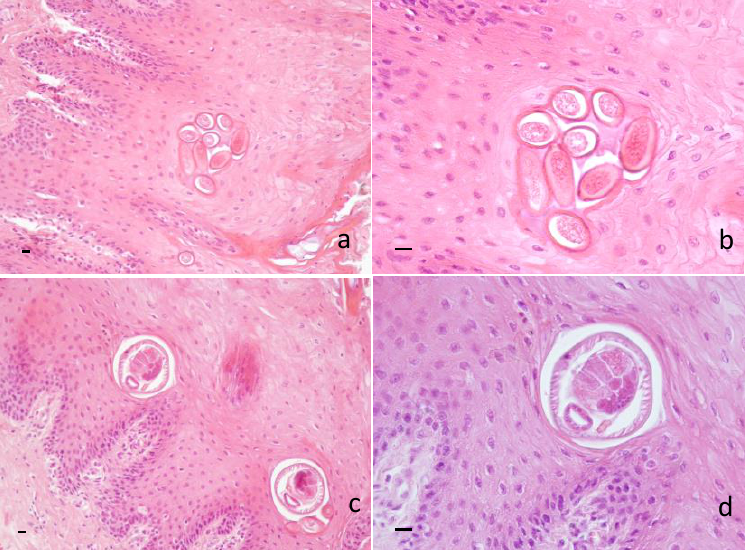
Figure 2. Wild boar. Histological section of tongue. ( a ) Barrel-shaped eggs of E. garfiai showing protruding polar plugs in the prickle layer of the epithelium. 20 × HE. Scale bar 10 µm; ( b ) eggs of E. garfiai 40 × HE. Scale bar 10 µm; ( c ) transversal section of adults of E. garfiai in the prickle layer of the epithelium. 20 × HE. Scale bar 10 µm; ( d ) transversal section of adult of E. garfiai 40 × HE. Scale bar 10 µm.